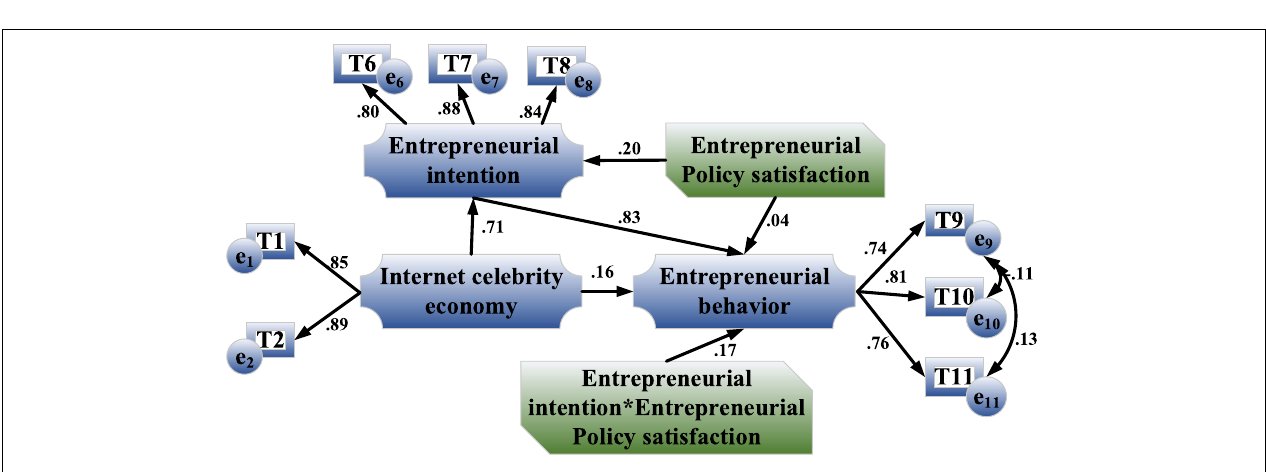
FIGURE 15 | Path coefficient diagram of the moderating effect of entrepreneurial policy satisfaction in the impact mechanism of entrepreneurial intention on entrepreneurial behavior.